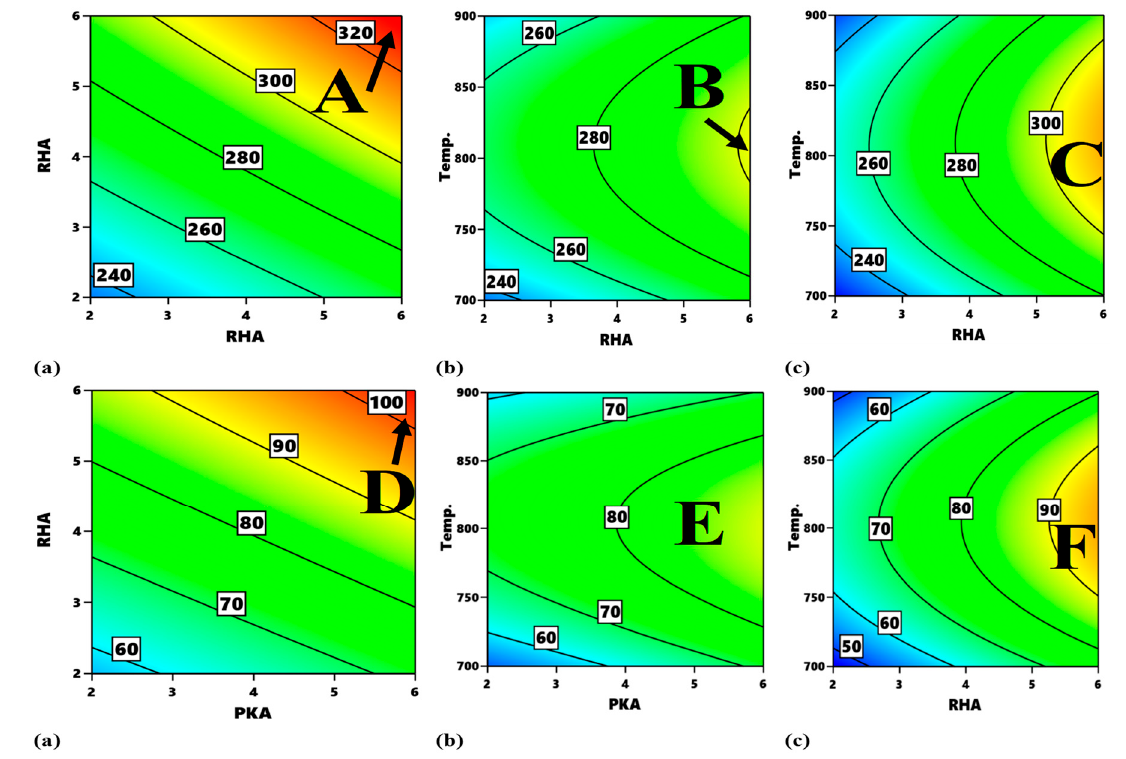
Figure 15. Contour plot for (top a – c ) compressive strength (bottom a – c ) compressive modulus.